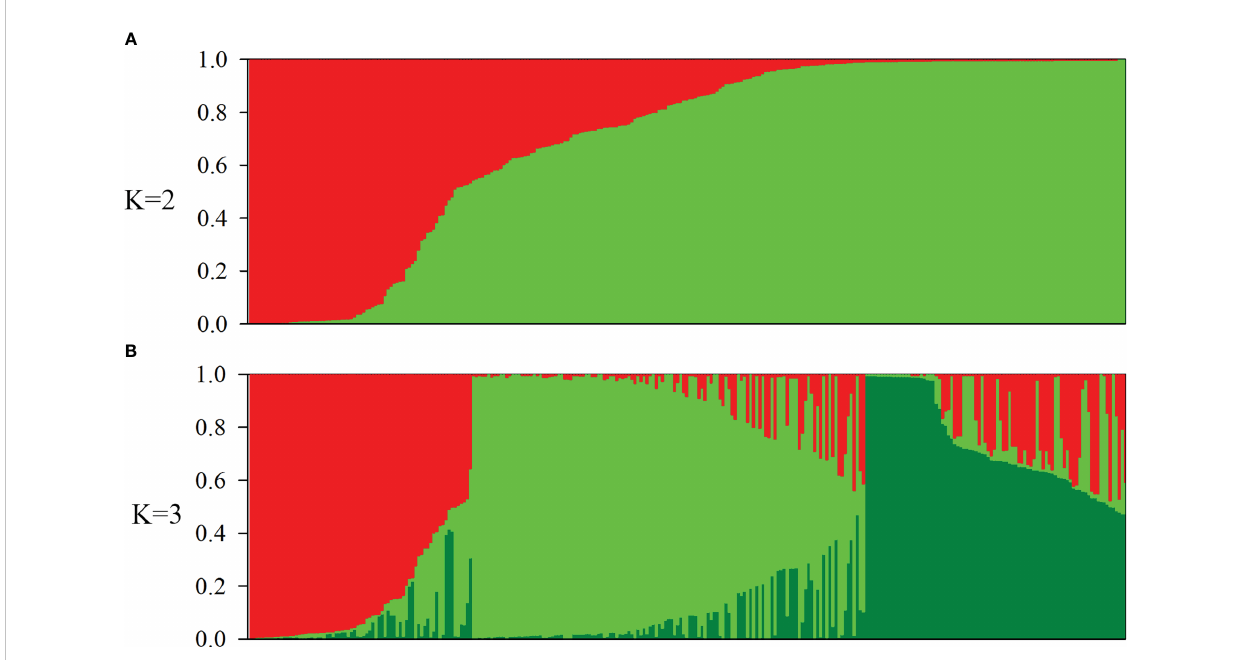
FIGURE 1 Population structure of 288 oat ( Avena sativa . L) accessions. (A, B) Population structure estimated using STRUCTURE and illustrated as bar plots (K = 2 and 3). Each accession is shown as a thin vertical segment, and the color indicates the proportion of each population. Each subgroup is represented by an individual